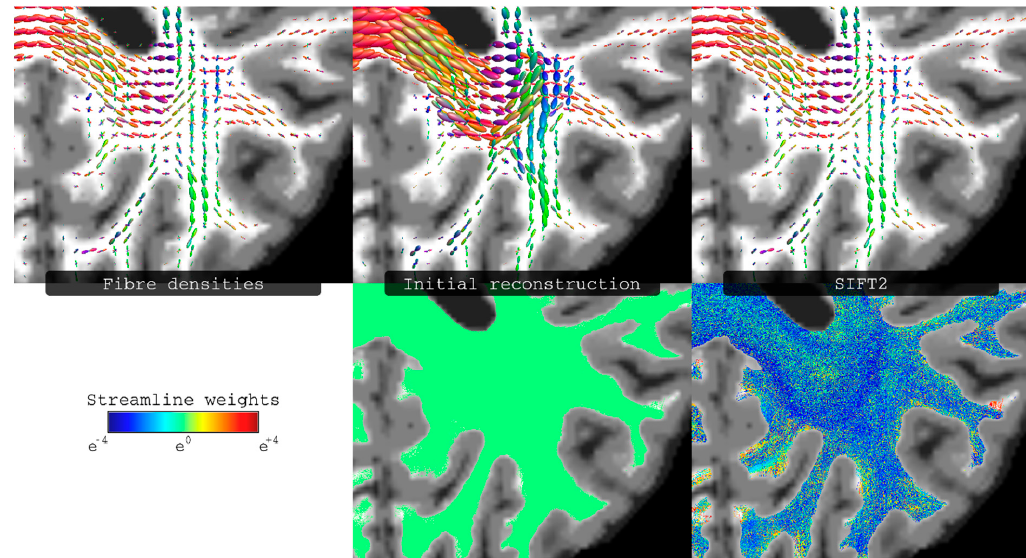
Figure 6. Illustration of the effect of Spherical-deconvolution Informed Filtering of Tractograms 2 (SIFT2) to the reconstructed tractogram. Top row: fibre densities as estimated from either the raw image data (left most), or the streamlines reconstruction (middle and right columns), i.e., representing the streamlines densities also as spherical distributions. Bottom row: streamlines reconstructions, with each streamline coloured according to its weighting coefficient (this is the same value for all streamlines in the initial reconstruction, and the computed streamline-specific weights for the SIFT2 case). Fibre densities shown in top row correspond to the results from spherical deconvolution (left), from the initial streamlines reconstruction (middle), and from the reconstruction with streamline weights determined using SIFT2 (right). Figure modified from a figure previously published in [43], with permission of Elsevier Inc, 2015.